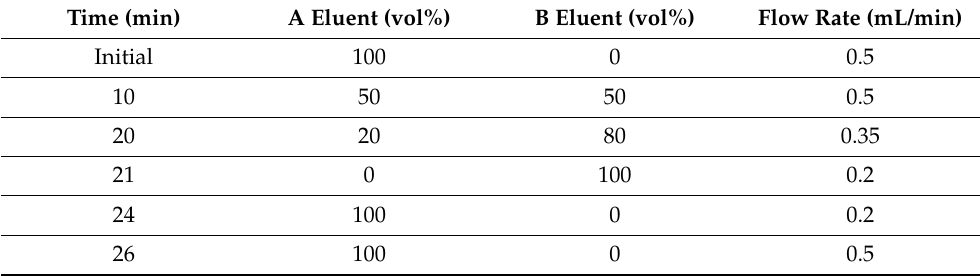
Table 1. Elution gradient for cardiolipin separation and analysis with